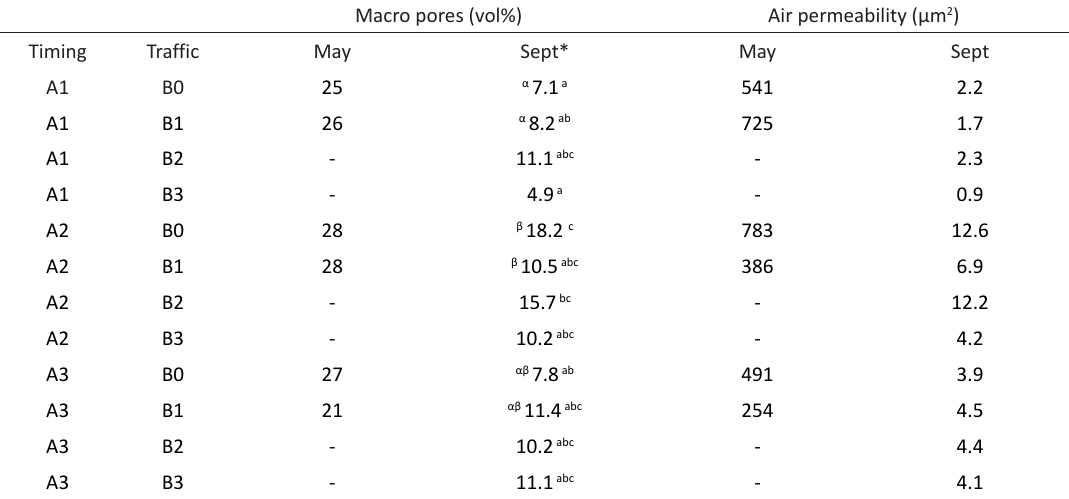
Table 3. Proportion of macro pores (>30 μm) and their corresponding air permeability (AirPerm), measured at –100 hPa matric potential at a depth of 0–5 cm in May and September 2016, affected by timing (Sowing date: A1 = early, A2 = medium, A3 = late) and traffic intensity (B0 = zero, B1 = one, B2 = two, B3 = three wheelings) during spring fieldwork in 2016